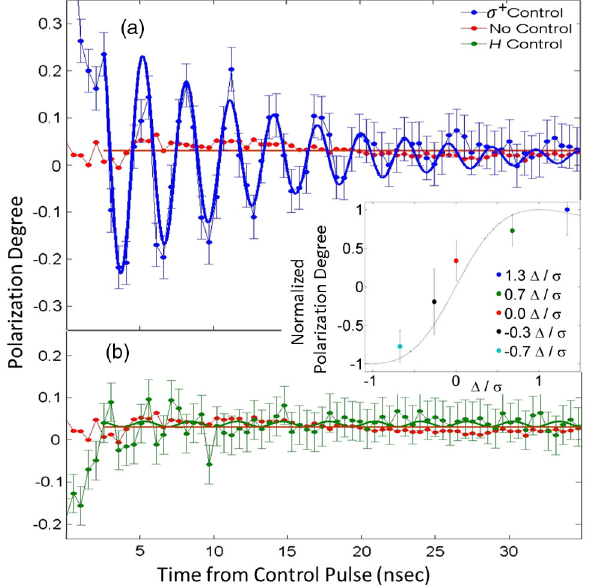
FIG. 7. Experimental demonstration of the DE spin control (a) [(b)] The measured (points) degree of circular polarization of the XX 0 emission as a function of time after the application of a T (cid:1) 3 σ þ -polarized (right-hand circularly) [ H -polarized (horizontal linearly)] control pulse (blue) [(green)], compared to that mea- sured in the absence of a control pulse (red). The solid line in (a) represents a decaying sinusoidal model fit. Note that while no polarization oscillations are observed for the linearly polarized control pulse, they are clearly visible for the circularly polarized one. Points (line) in the inset show the measured (model) dependence of the normalized oscillation amplitude on the